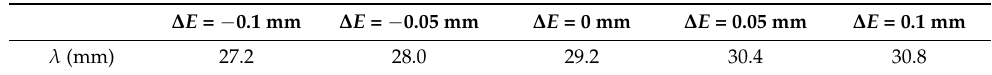
Table 7. Crack location considering various offset errors.